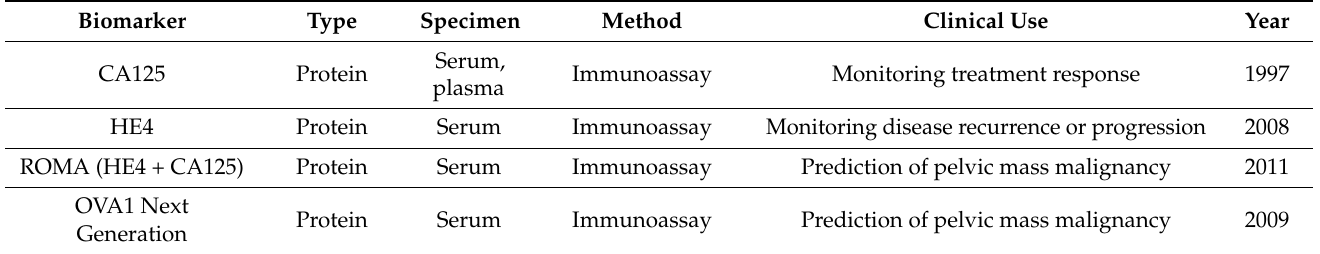
Table 1. List of protein biomarkers approved by the U.S. Food and Drug Administration (FDA) in ovarian cancer [30].